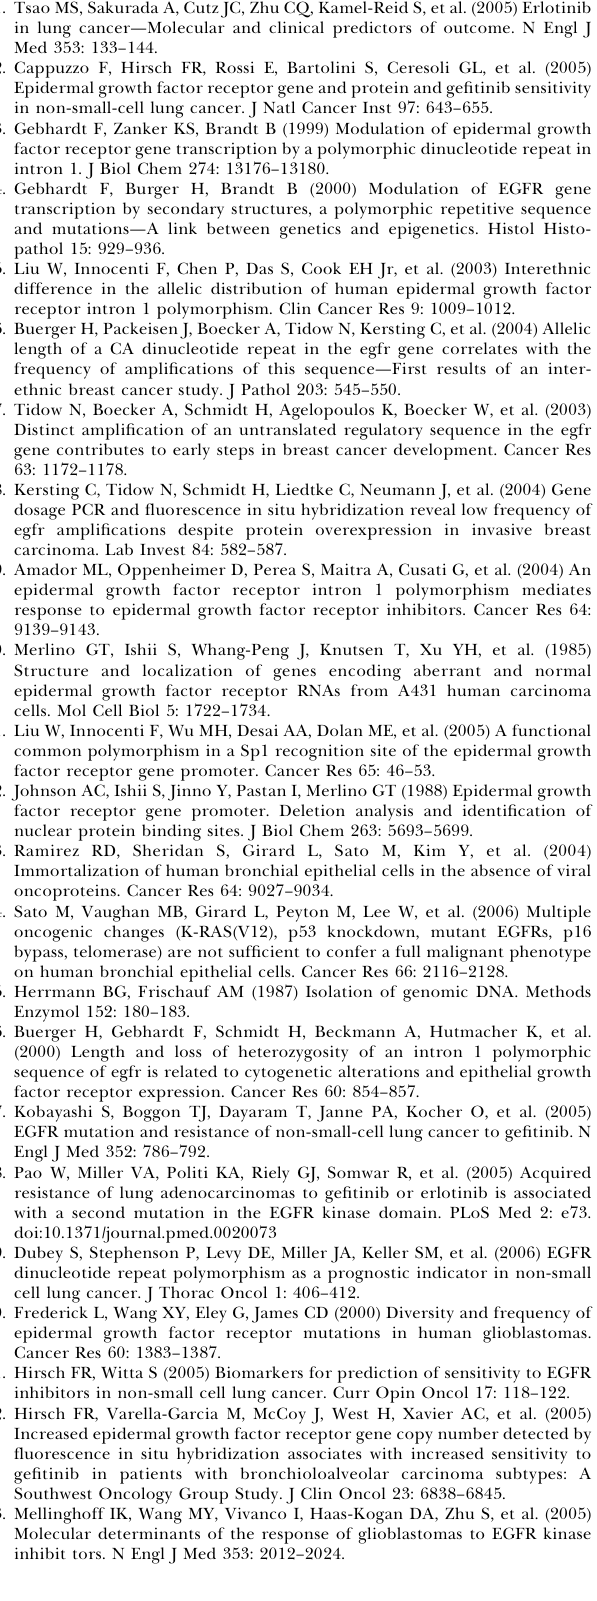
Figure S1. The Prognosis of Patients Based on the Average Length of the Shorter Allele of CA-SSR1 Overall survival curves for patients having a short allele of CA-SSR1 under versus over the average length (17.5). Survival was not influenced by the minor forms of the (cid:2) 191 or (cid:2) 216 polymorphisms (data not shown). Note that none of the patients received TKI therapy. Found at doi:10.1371/journal.pmed.0040125.sg001 (86 KB